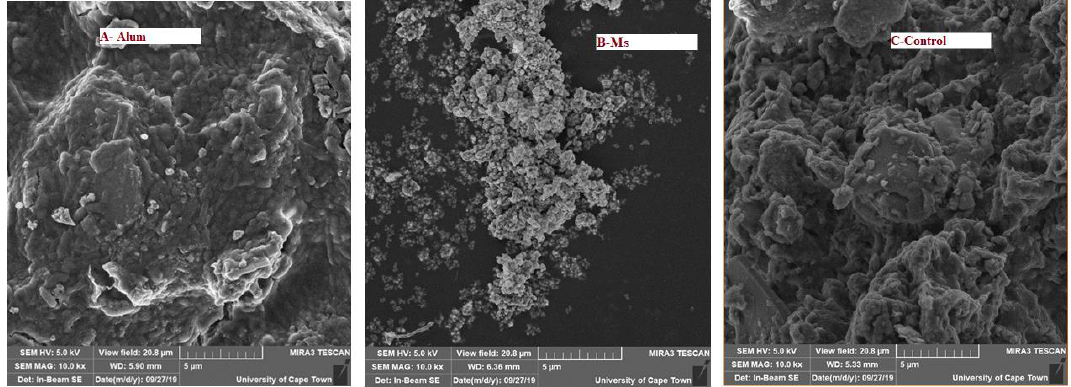
Figure 8. Scanning electron microscopy (SEM) images of digested sludge from magnetized biochemical methane potential (MBMP) setups of ( A ) Alum, ( B ) Ms and ( C ) Control.